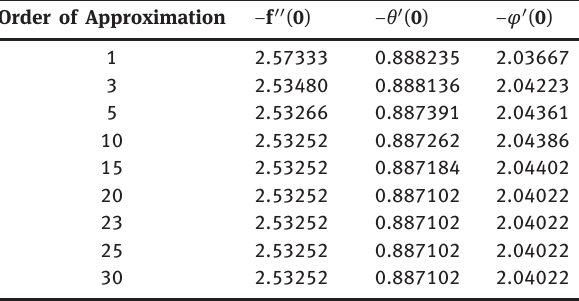
Table 1: Convergence of series solution for different order of